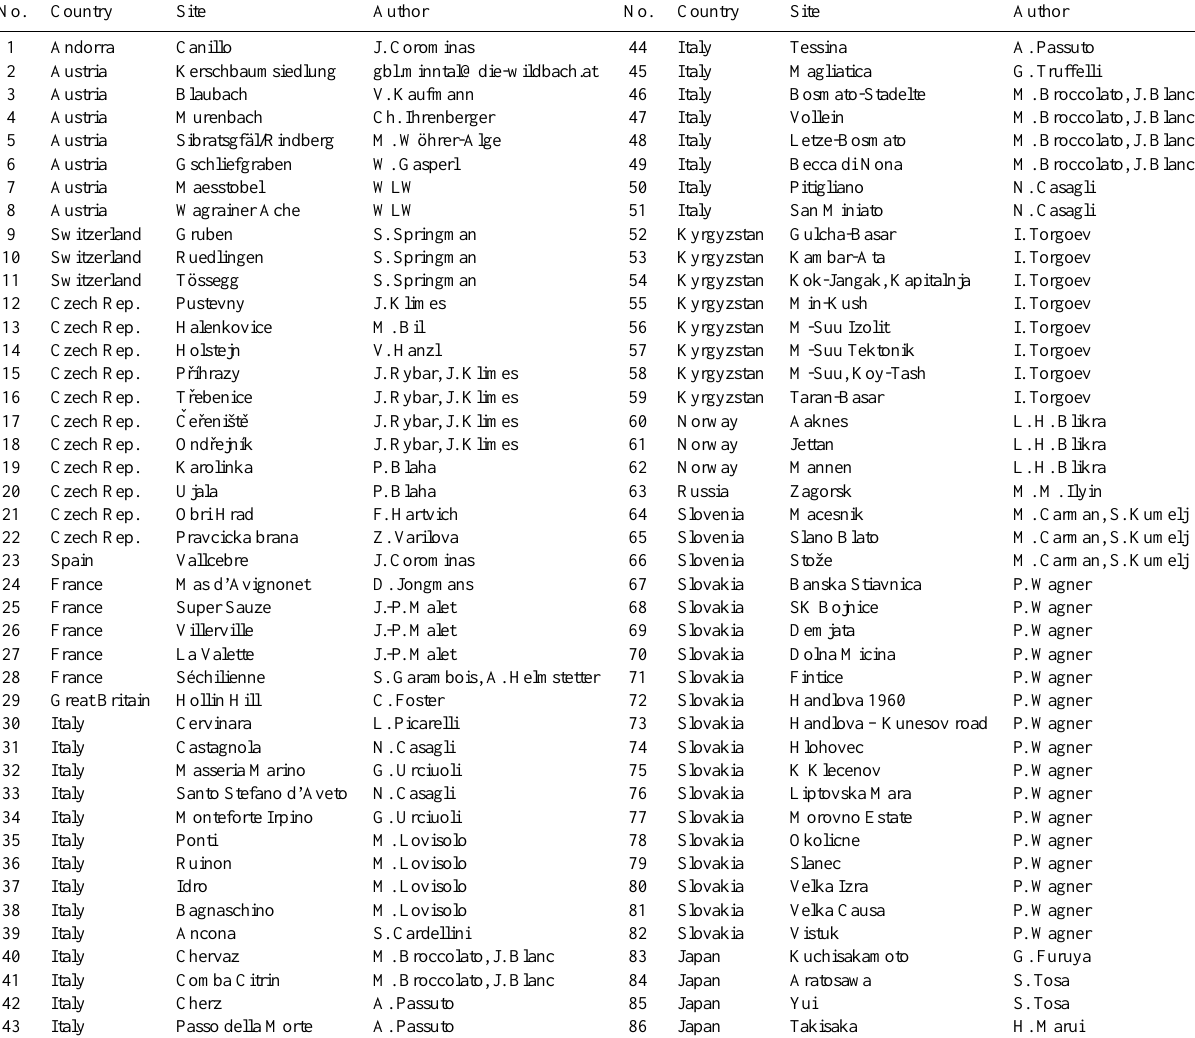
Table 1. Review of responses: countries, monitored sites and authors.